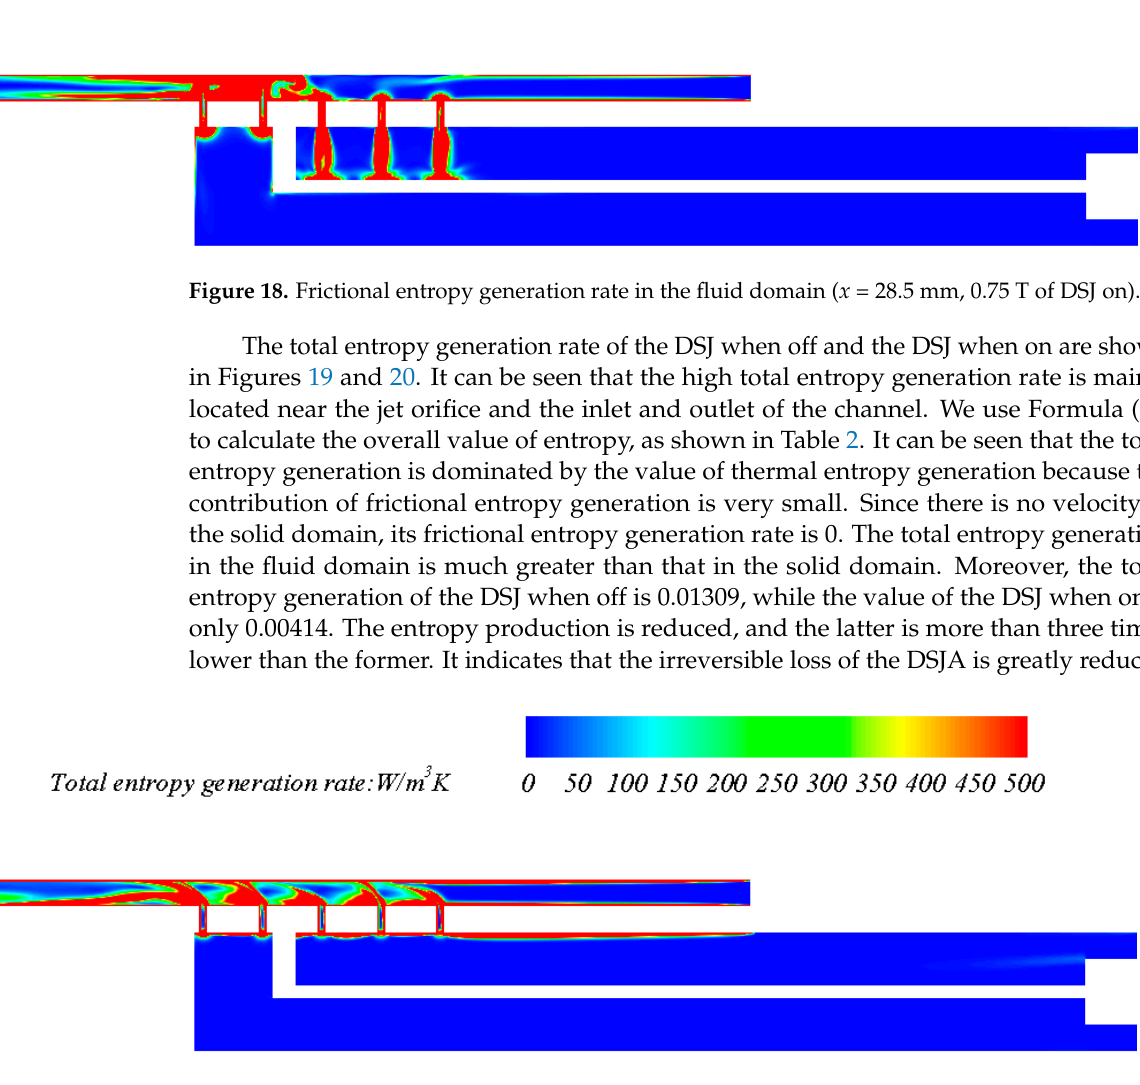
Figure 20. Total entropy generation rate in the fluid domain ( x = 28.5 mm, 0.75 T of DSJ on). Table 2. Thermal entropy generation, frictional entropy generation, and total entropy generation in different areas of the cooling device. Case